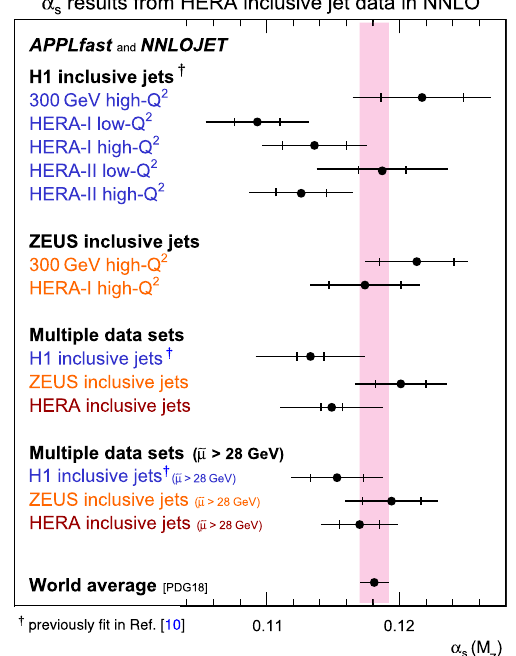
Fig. 5 Summary of α s ( M Z ) values in comparison with the world aver- age value. The inner error bars indicate experimental uncertainties, and the full errors the total uncertainty, comprised of the experimental and theoretical uncertainties. The lower set of values represent fits to data restricted to ˜ μ > 28 GeV